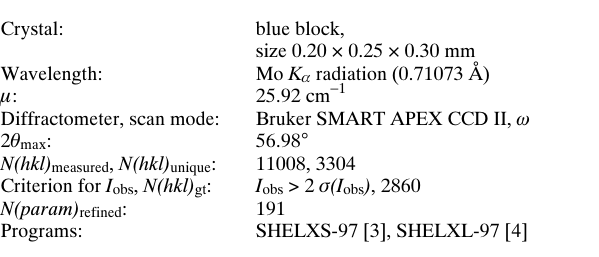
Table 1. Data collection and